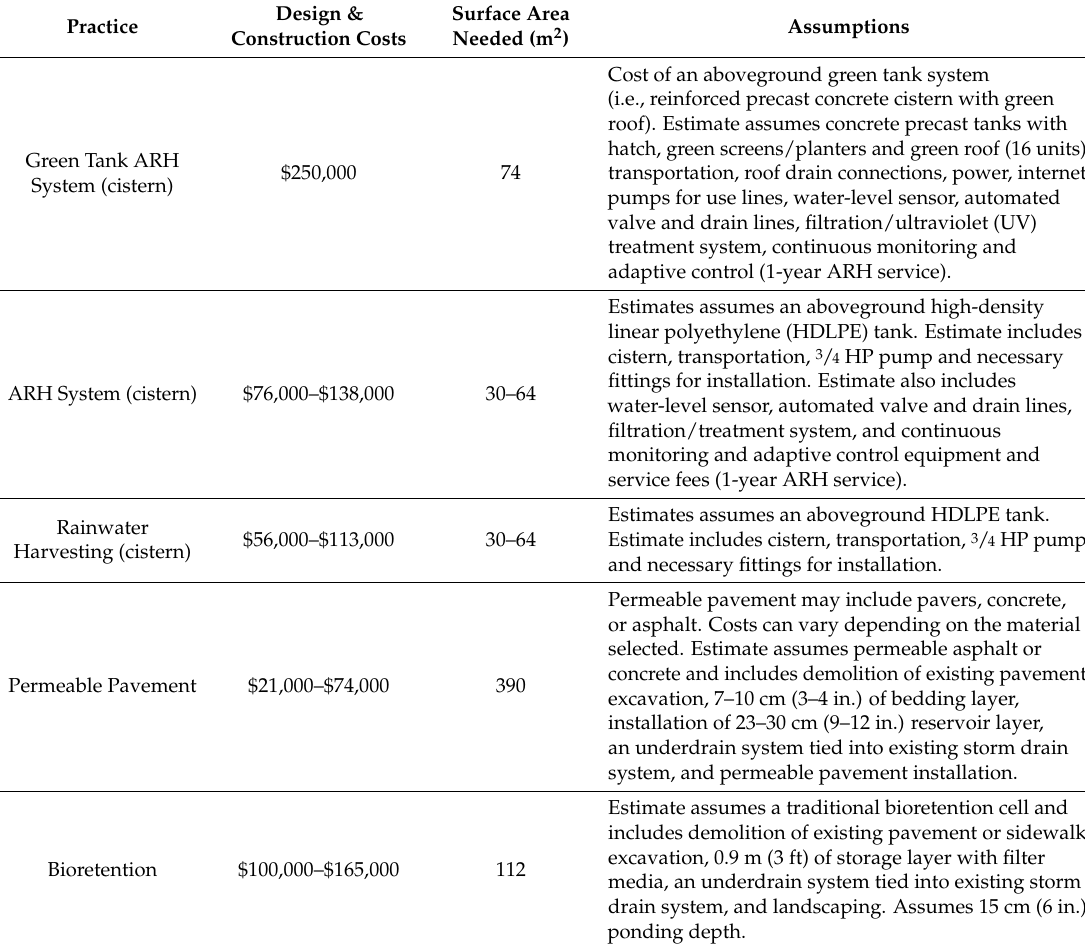
Table 2. Comparison of ARH System with Other low impact development (LID)